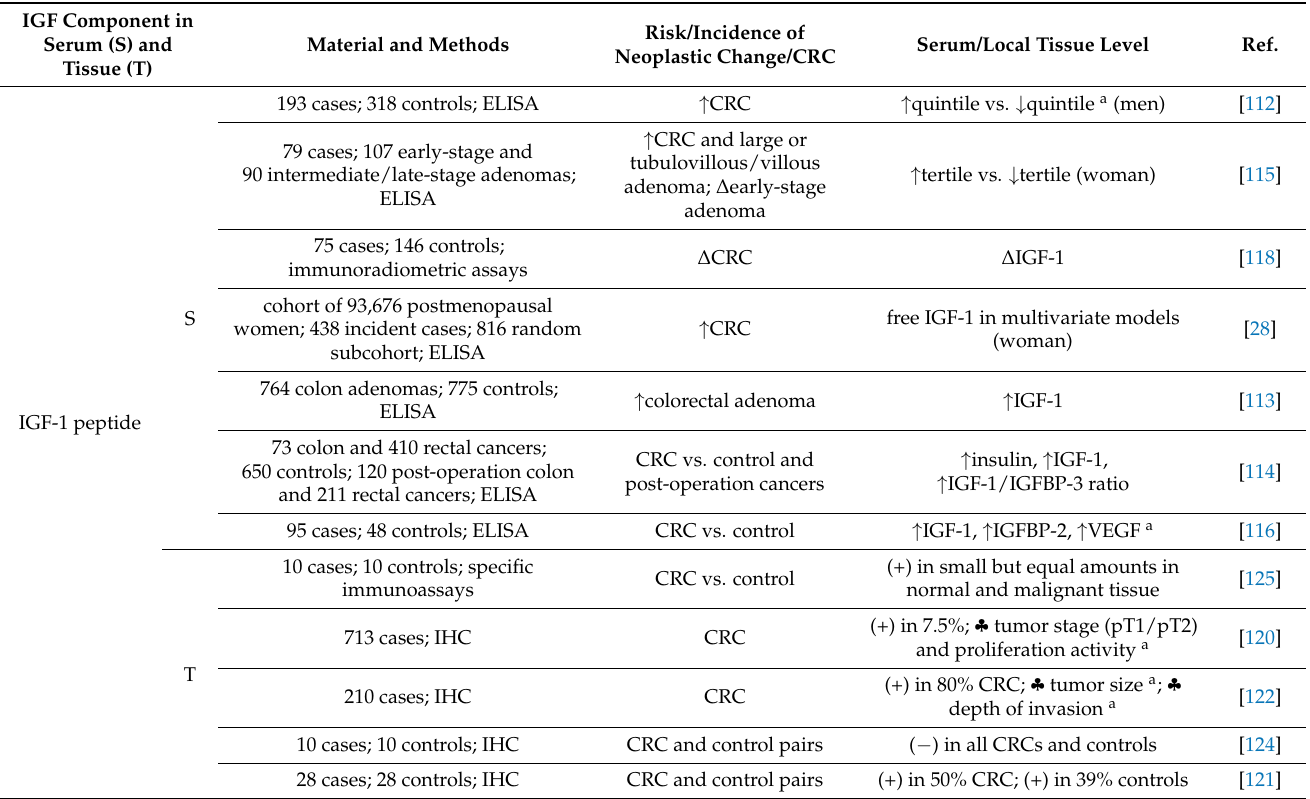
Table 1. Summary of the possible association between IGF-1, IGF-1R, and IGFBP-3 and colorectal carcinogenesis in vivo. IGF Component in Risk/Incidence of Serum/Local Tissue Level Ref. Serum (S) and Material and Methods Neoplastic Change/CRC Tissue (T)